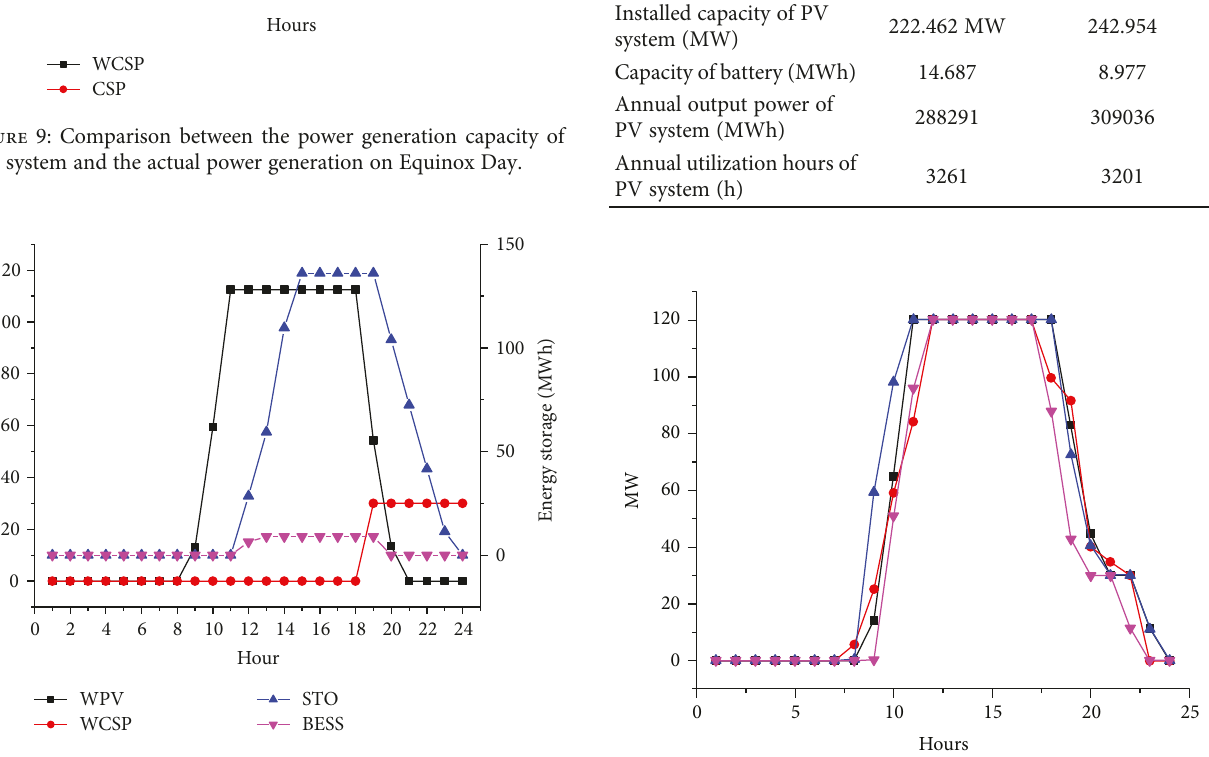
Figure 10: Output power of the system on Equinox Day of whole year optimization.